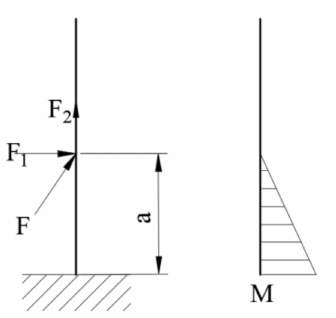
Figure 14. Cutting height versus peak cutting force. Note: branch diameter is 9–10 mm; wedge angle is 25 ◦ ; average cutting speed is 3.36 m · s − 1 ; slip cutting angle is 20 ◦ ; cutting height is 5 cm, moisture content is 26.8%–28.9%.